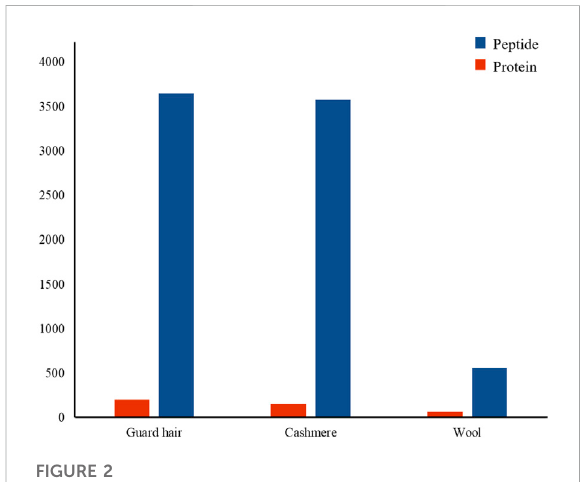
Protein identi fi cation and analysis in the hair fi bers of sheep and goats.